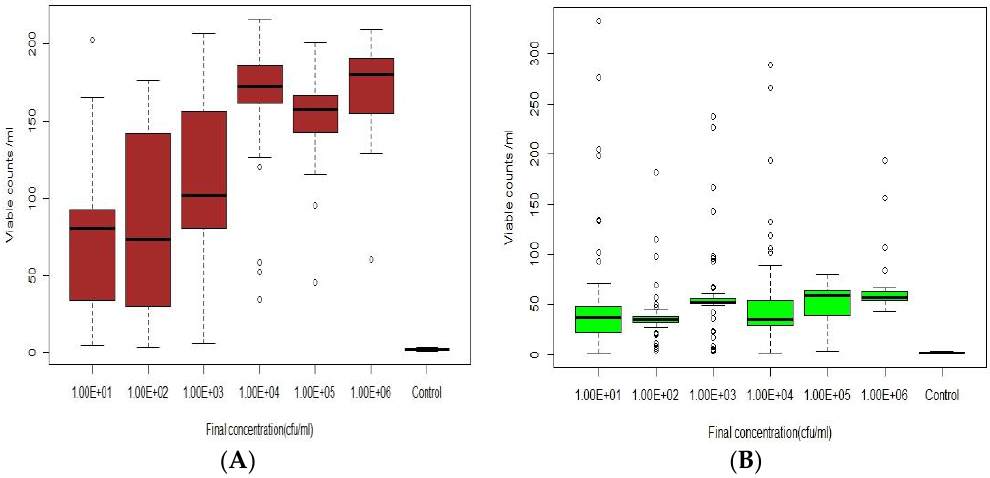
Figure 3. The sensor B response to E. coli spiked in Deionized (DI water: A ) With Tryptic soy Broth (TSB) growth media (dirty) and ( B ) Washed cells (clean).